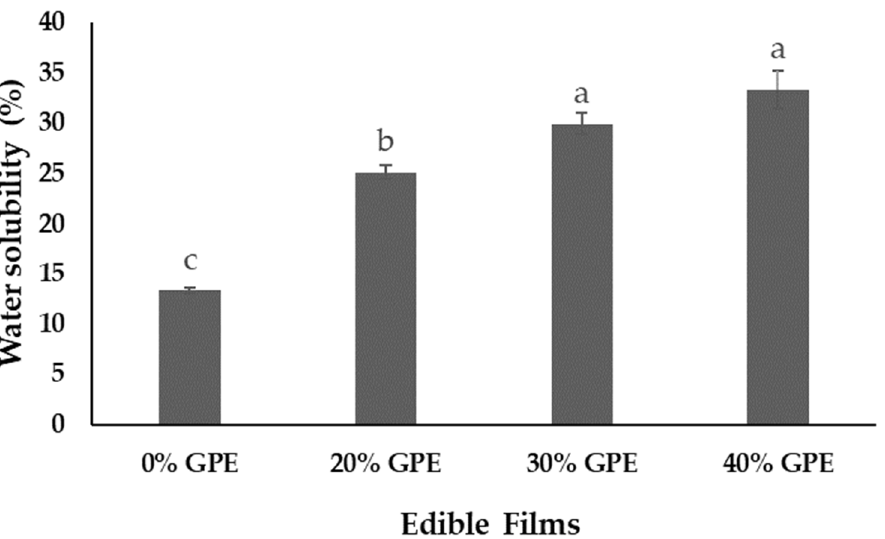
Figure 3. Water solubility of edible films of arrowroot ( Maranta arundinacea Linn.) starch with 0, 20, 30, and 40% of grape pomace extract (GPE). Values with the same letter in the columns do not statistically differ by Tukey’s test ( p < 0.05).